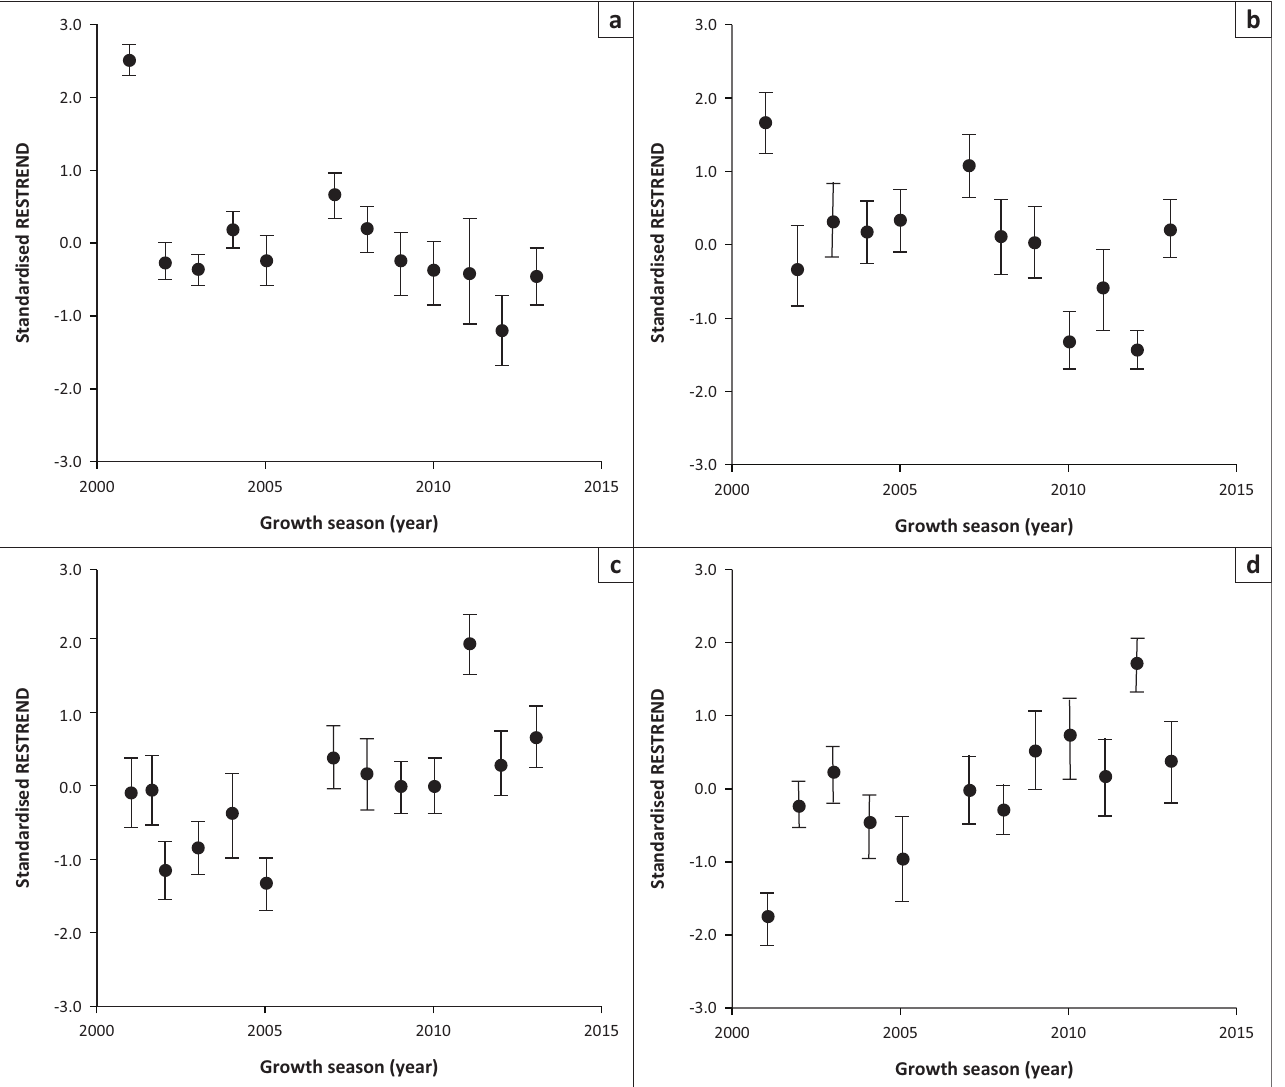
FIGURE 9: Examples of significant trends in standardised residual trend analysis values over time from several areas with significant decreasing trends (graphs a and b) or increasing trends (graphs c–g) in the Tswalu Kalahari Reserve. Values are shown as mean (± standard deviation) for each area. (a) East of Rogella Pan, (b) Kalkpan, (c) South-west, (d) Tarkuni, (e) South-east, (f) Dedeben and (g) Langkloof/Bruwer. (h) The small map indicates the general area covered by each graph.